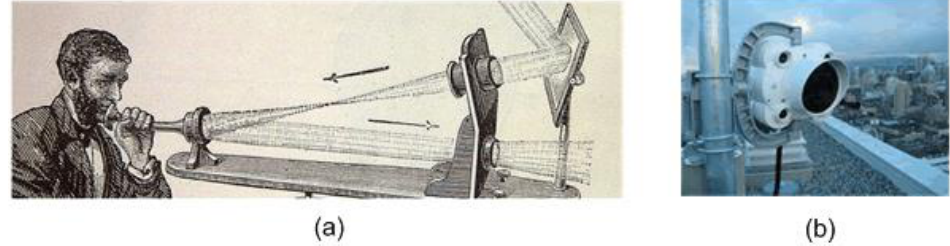
Figure 2. ( a ) Acoustic wave transmission over a light beam [4]; and ( b ) today’s UOC transceiver roof-top system [5].